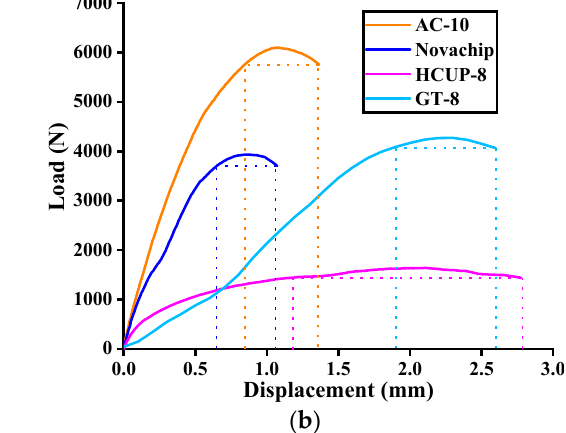
0.0 0.5 1.0 1.5 2.0 2.5 3.0 3.5 4.0